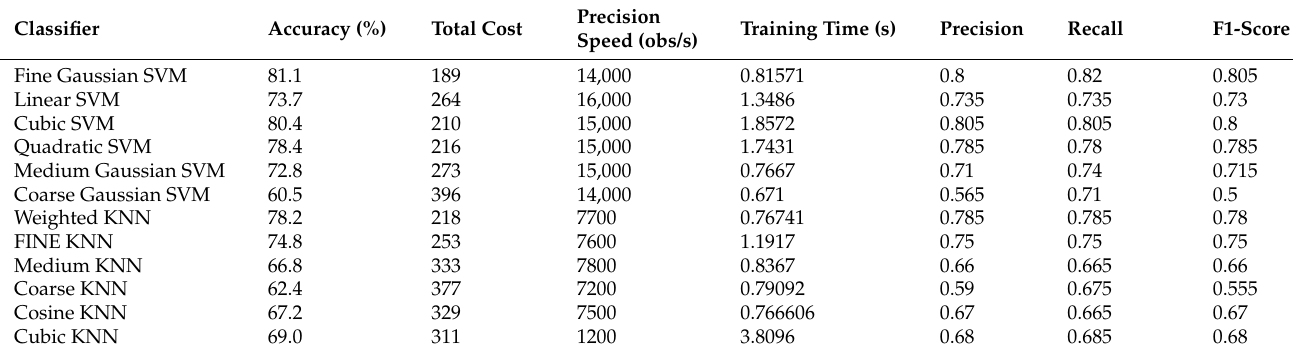
Table 6. Experiment_2 using 5 Folds (200 Feature).